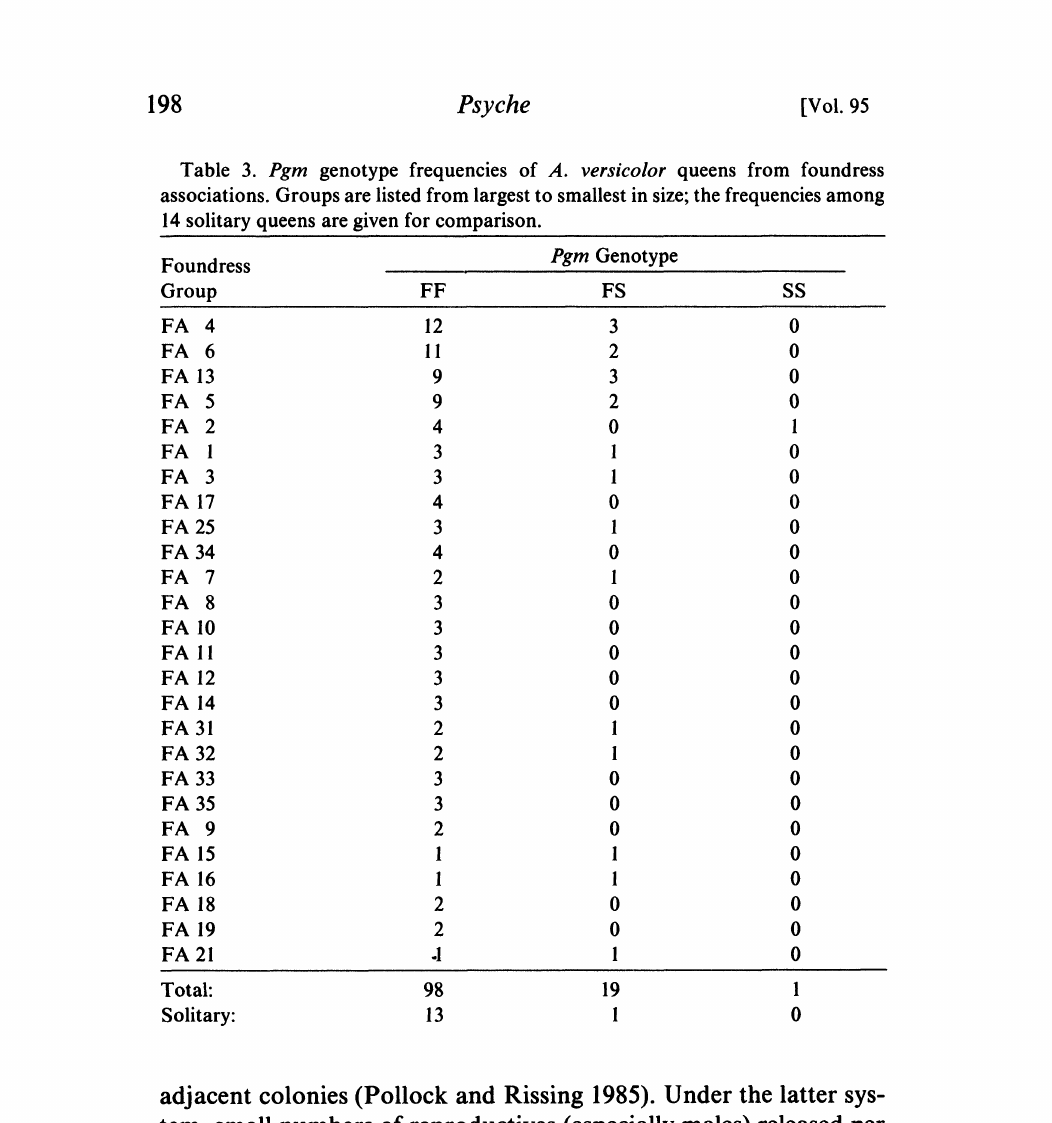
Table 3. Pgm genotype frequencies of A. versicolor queens from foundress associations. Groups are listed from largest to smallest in size; the frequencies among 14 solitary queens are given for comparison. Pgm Foundress